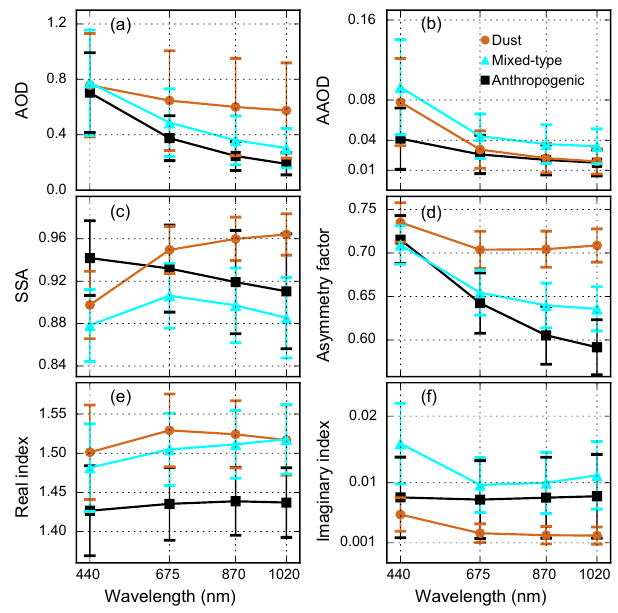
Figure 3. Spectral behavior of (a) AOD, (b) AAOD, (c) SSA, (d) asymmetry factor, (e) real part of the complex refractive in- dex, and (f) imaginary part of the complex refractive index for dust, mixed-type, and anthropogenic aerosols averaged from East Asian